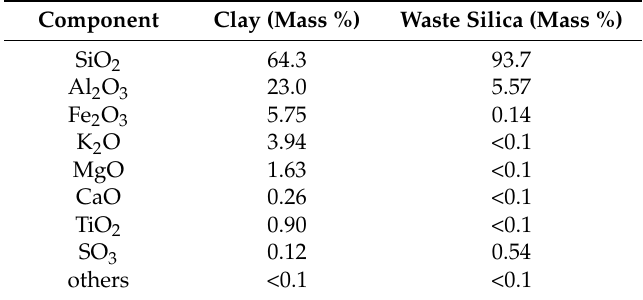
Table 1. Compositions of inorganic substances in the clay and waste silica powder. Component